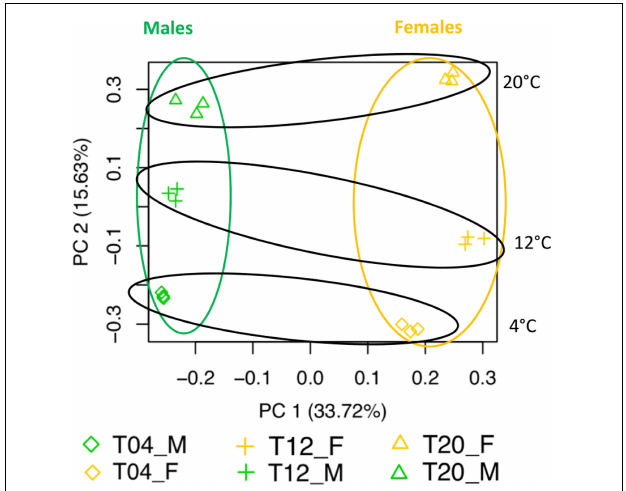
FIGURE 1 | Principal component analysis of the counts per million in the treatments ( n = 3) after 14 days in the experimental temperature treatment. Orange: female samples, green: male samples.